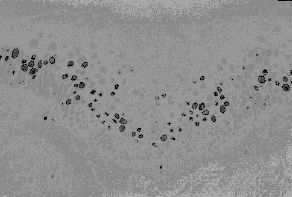
Fig. 5. PCNA expression in odontogenic keratocyst. Cystic epithelial lining shows a predominantly suprabasal cell labelling pattern. ABC method with methyl green counterstain, ×